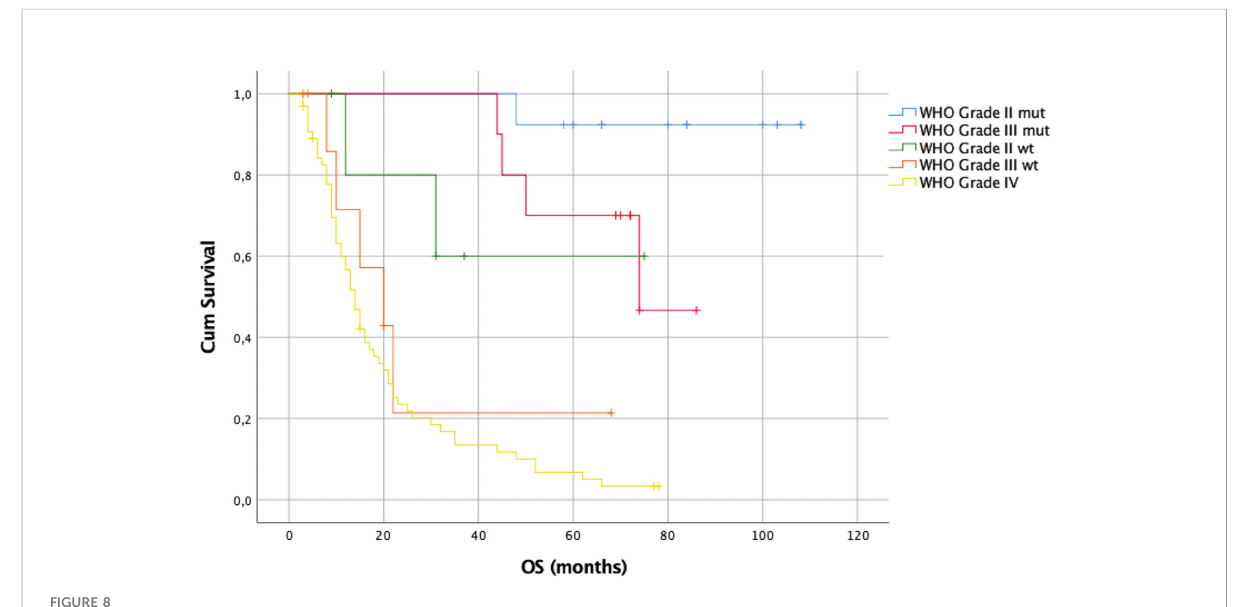
FIGURE 8 Kaplan – Meier curves of OS of patients at fi rst